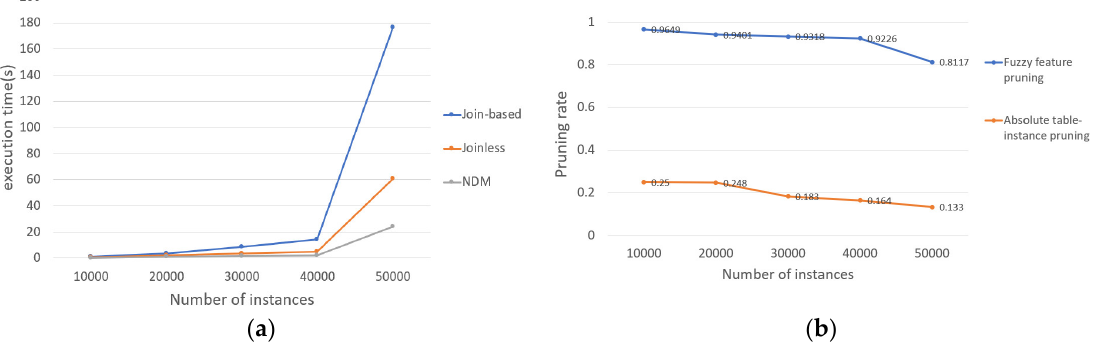
Figure 13. ( a ) Effect of the number of instances; ( b ) Pruning degree of the two strategies.